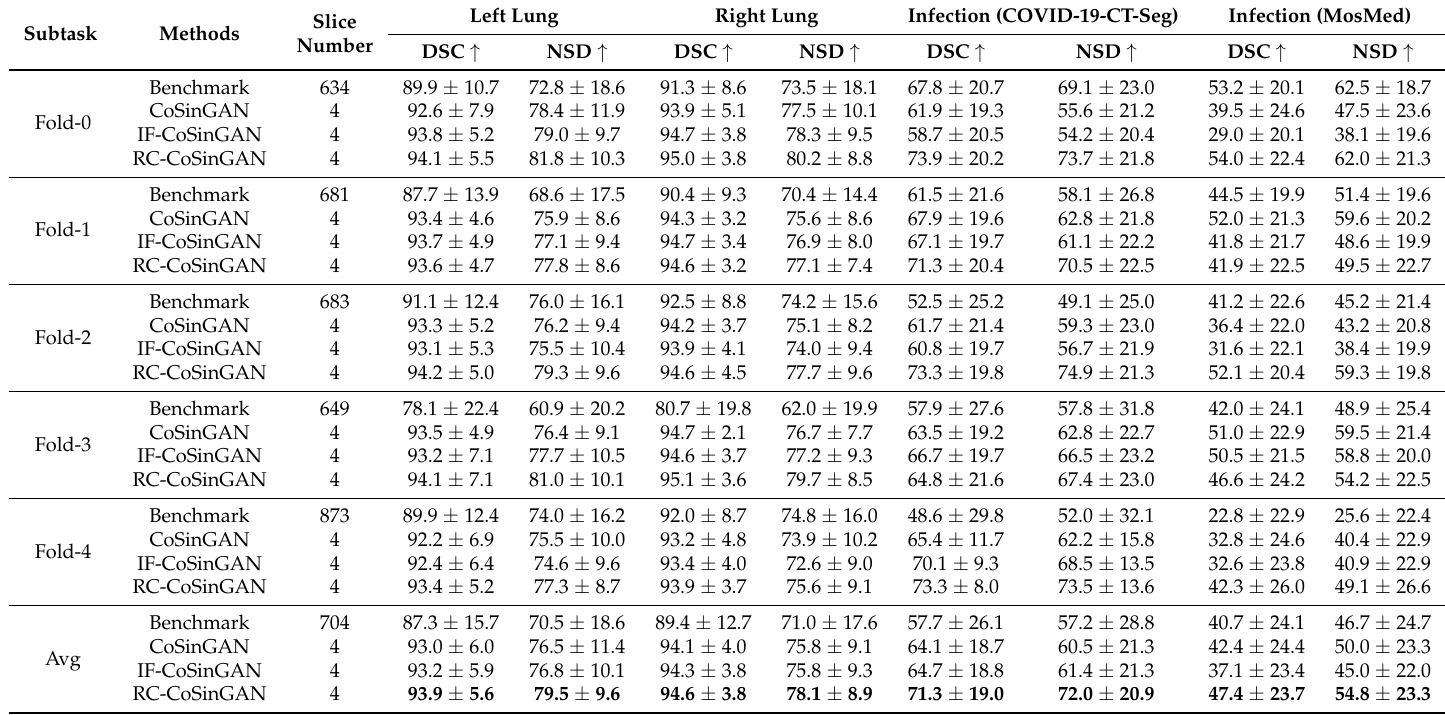
Table 5. Quantitative results (Mean±Standard deviation) of 5-fold cross validation and independent testing based on 2D U-Net. For each fold, average DSC and NSD values are reported. The last row shows the average results of 80 (=5 folds × 16 testing cases per fold) testing cases in the COVID-19-CT-Seg dataset and 250 (=5 folds × 50 testing cases per fold) testing cases in the MosMed dataset. The third column shows the number of real labeled CT slices used for training. ↑ denotes a higher score that admits better segmentation performance. The entries in bold highlight the best average